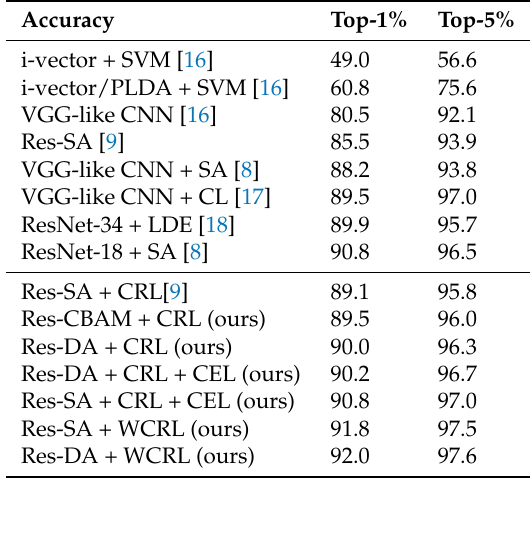
Table 8. Speaker identification results on the VoxCeleb1 dataset (higher is better).